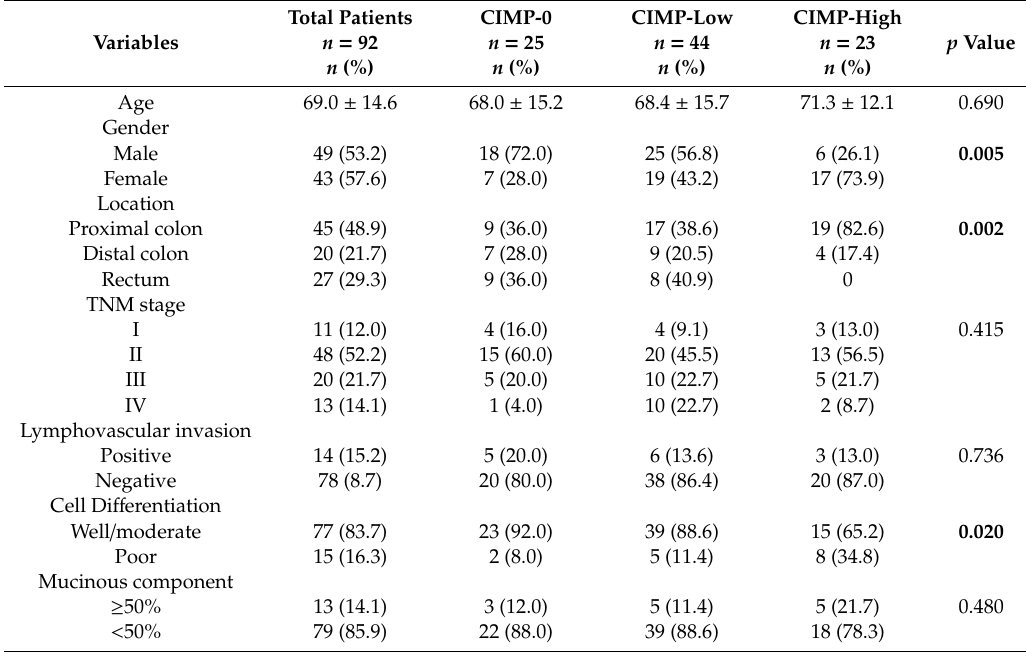
Table 1. Clinicopathological features of microsatellite instability (MSI)-high colorectal cancers